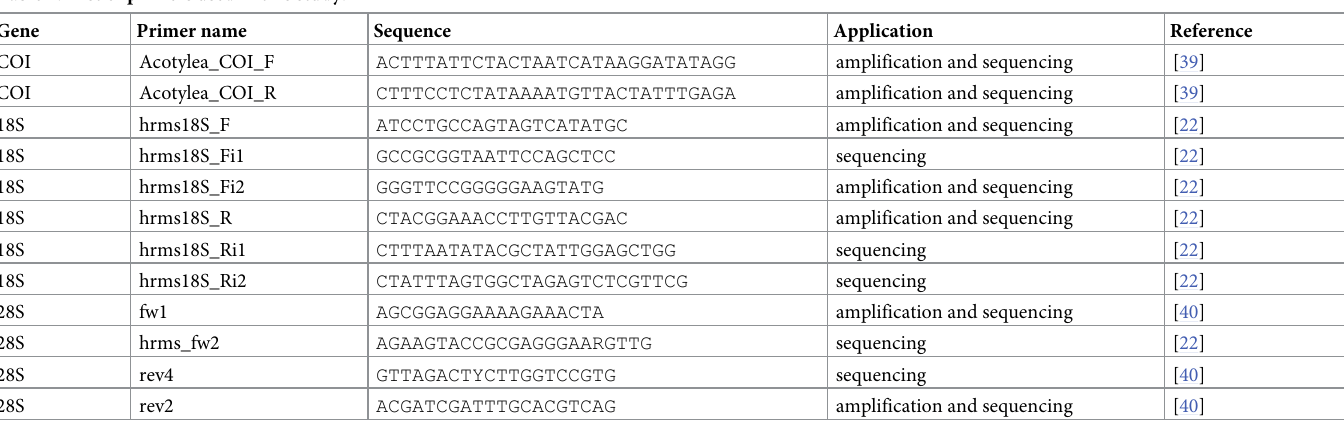
Table 2. List of primers used in this study.